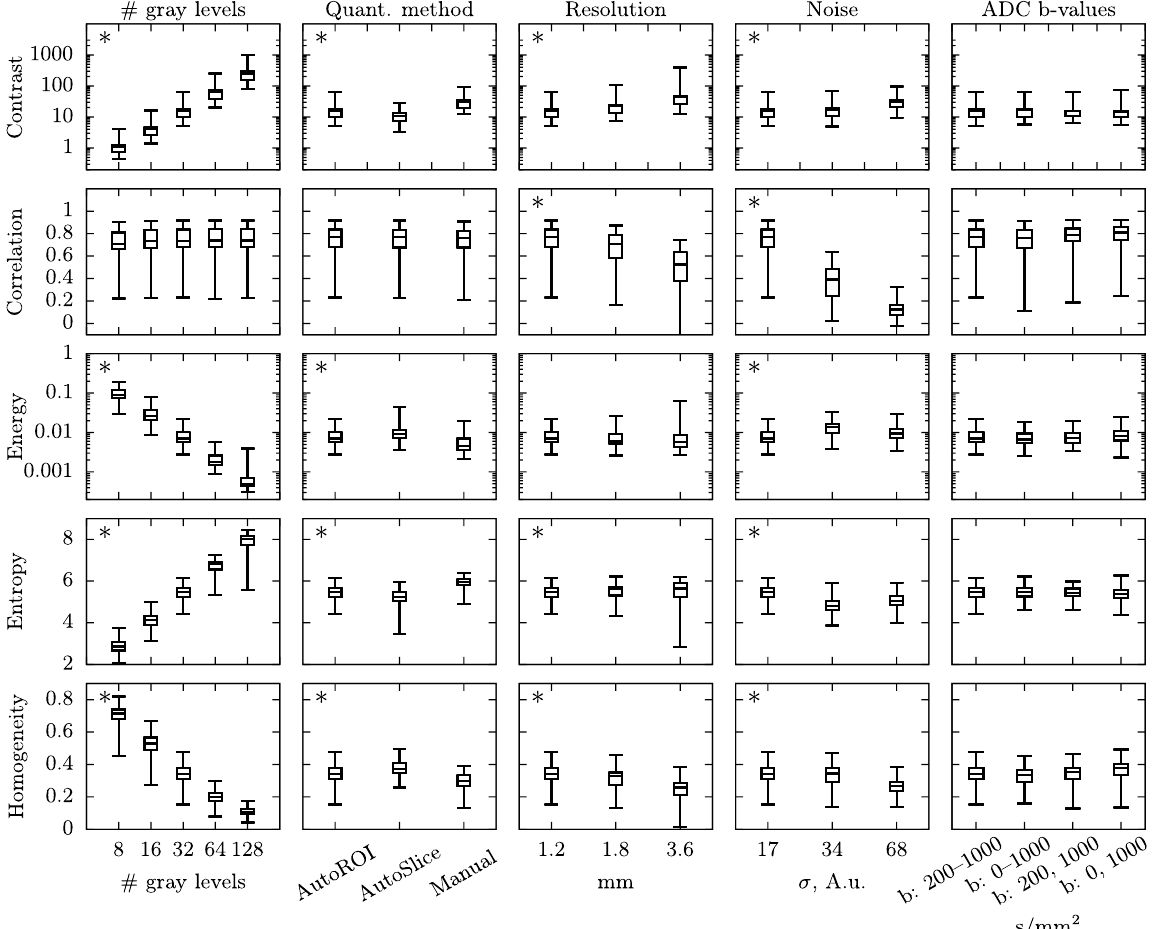
Figure 1. Changes in texture feature distributions with different imaging and pre-processing settings. The box plots show the distribution of contrast, correlation, energy, entropy and homogeneity for the 72 ROIs in the glioma data set. The box shows the first and third quartiles, with the median value indicated by the center line. The whiskers show the extreme values. An asterisk in the upper left corner indicates that at least one pair of settings is significantly